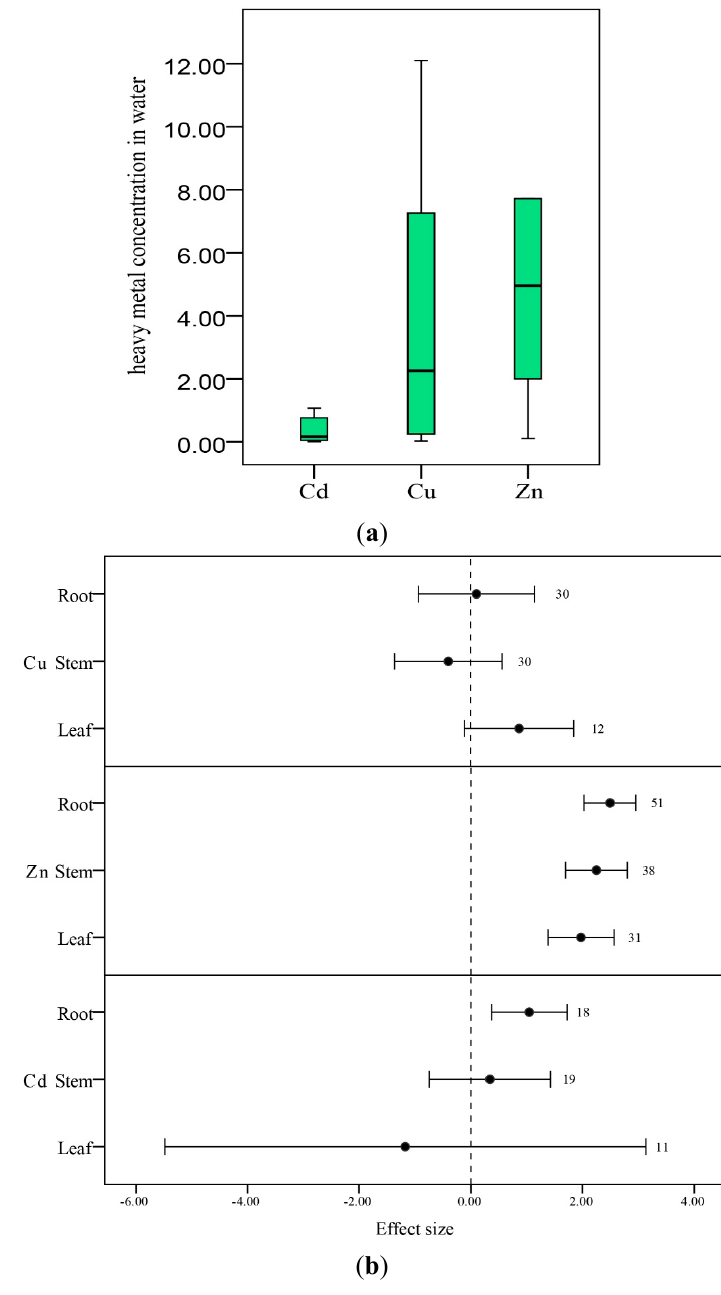
Figure 3. ( a ) The Cu, Zn and Cd concentration in water (mg·L − 1 ). The whiskers represent the range, the hinges represent the inter-quartile range (IQR), and the middle line represents the median. ( b ) The mean bioconcentration ratio values of heavy metals Zn, Cu, and Zn concentration on aquatic plant organs categorized by root, stem, and leaves. Error bars represent 95% bootstrapped confidence intervals (CIs). The effect of heavy metal concentration ability in aquatic plants was considered significant if the 95% CI of the effect size did not overlap with zero. The number of observations for each category is shown next to the error bars.